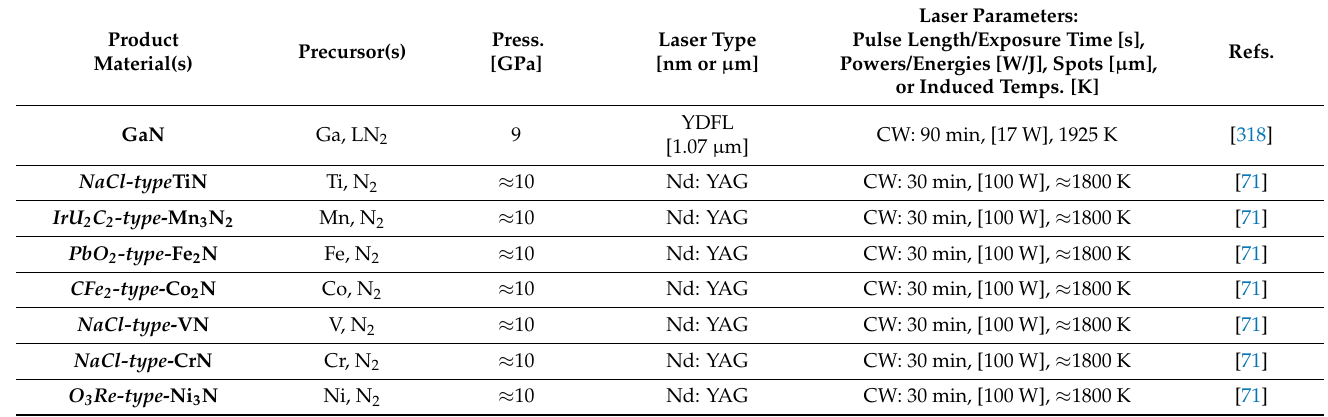
Table 6. Binary Transition Metal Nitrides: Transition Metal Nitrides Synthesised During Selected LRS-DAC Studies.